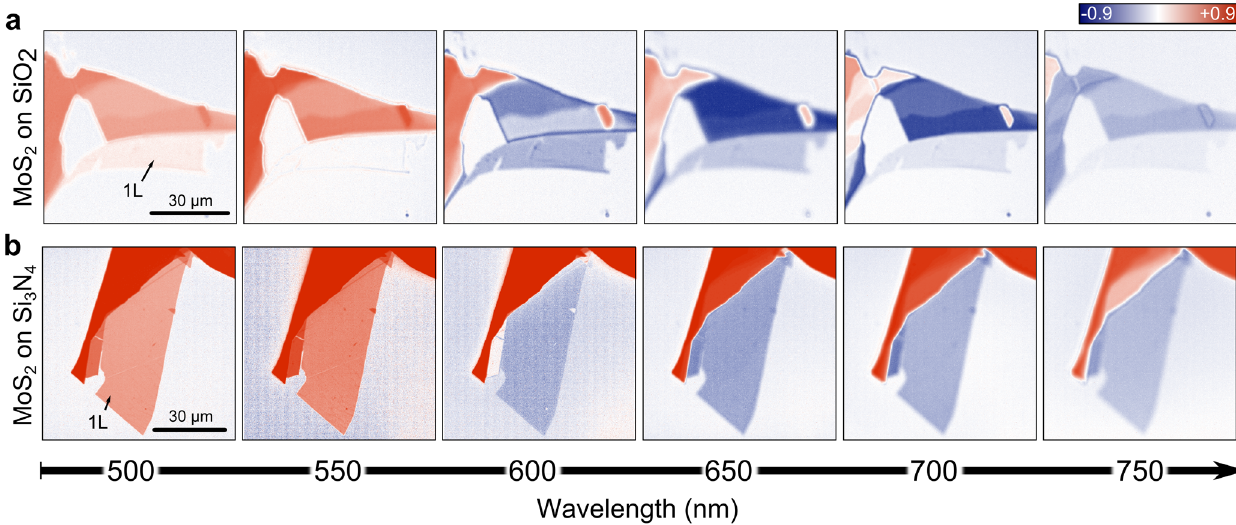
Figure 3. Contrast maps obtained by hyperspectral imaging of MoS 2 flakes on Si